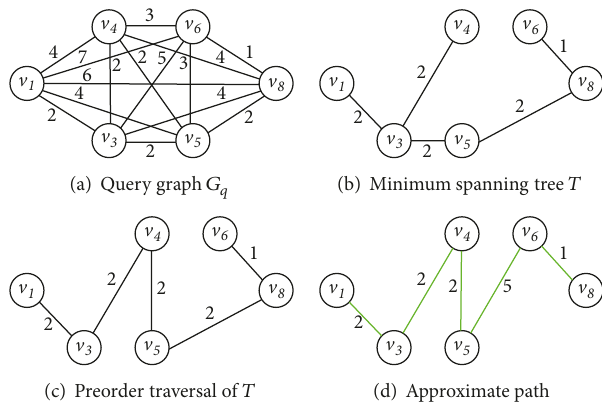
Figure 3: An example of an approximate